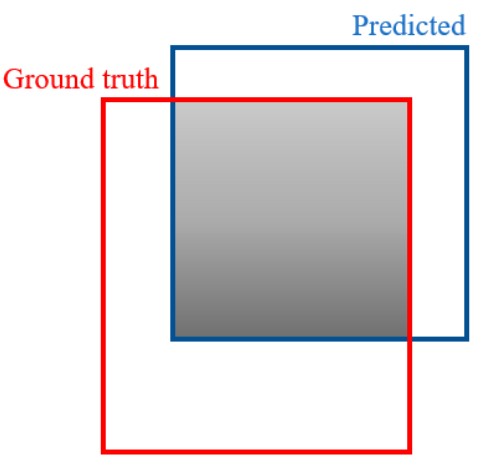
Figure 3. Intersection of union.